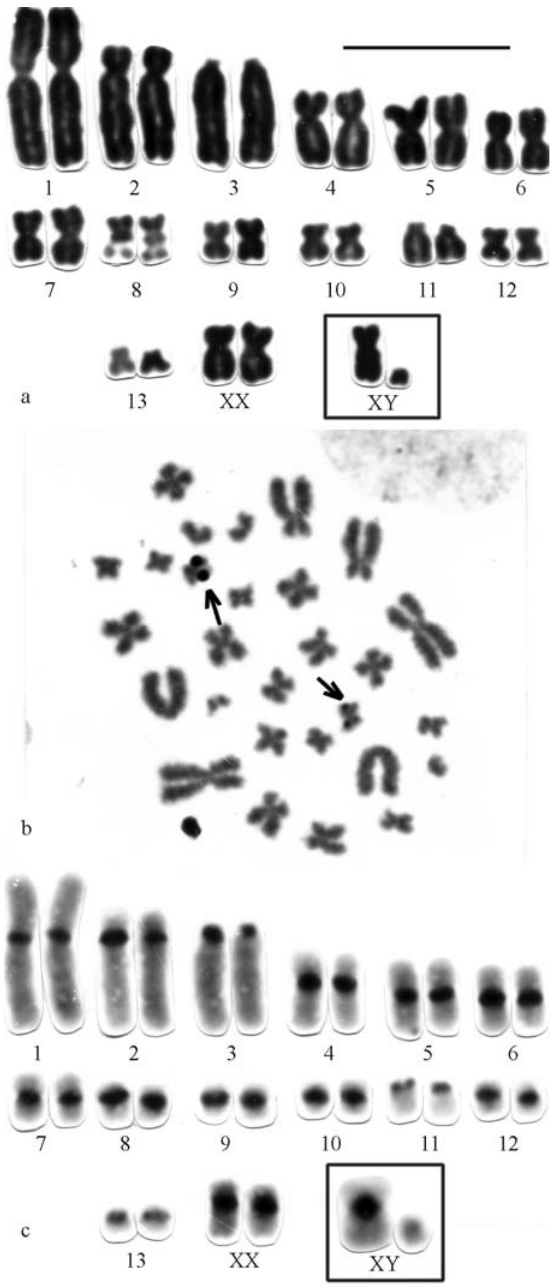
Figure3(a-c) -KaryomorphAwith2n=28,FN=48:a)tod) Proechimys longicaudatus from Usina Hidrelétrica Samuel (RO). a) Karyotype con- ventionally stained. Note secondary constriction in chromosome pair 8; b) Heteromorphic Ag-NORs in the distal region of the long arm of chromo- some pair 8 (arrows); c) C-banding pattern. Bar = 10 (cid:1)